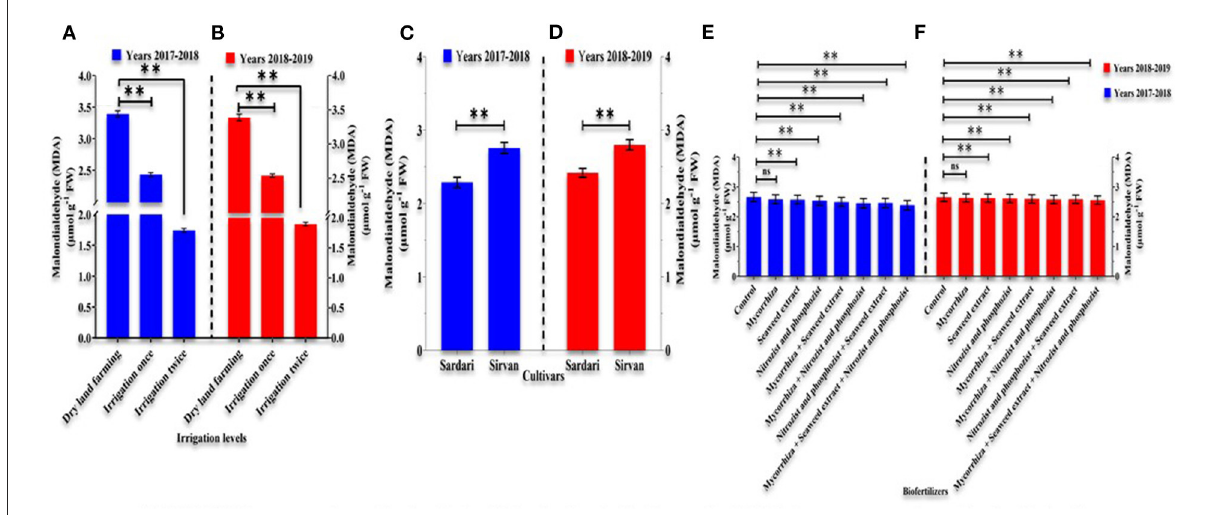
FIGURE2 Mean comparisons of main effects of irrigation levels (A,B) on malondialdehyde, mean comparisons of main effects of cultivars (C,D) and bio-fertilizers (E,F) on malondialdehyde in wheat plant in the years 2017–2018 and 2018–2019. At p > 0.05, ns, not significant; and **0.001 < p ≤ 0.01.